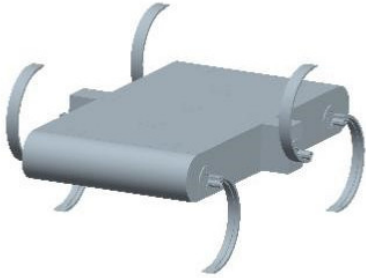
Figure 1. Overall design of the robot.